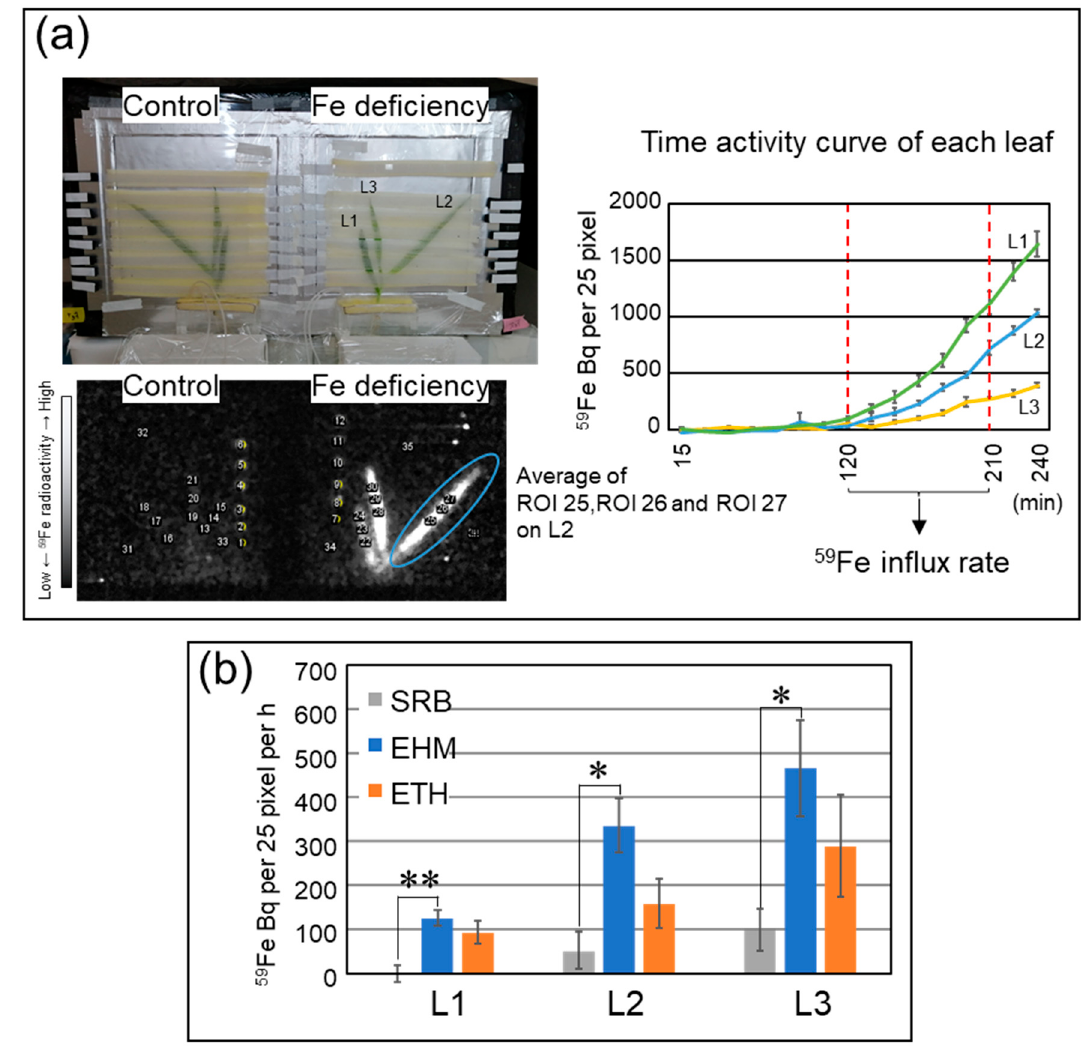
Figure 3. 59 Fe influx rate of Fe-deficient leaves detected by live-autoradiography. ( a ) Scheme for calculation of 59 Fe influx rate to leaves. Three regions of interest (ROIs) of 16 mm 2 (4 mm × 4 mm = 5 × 5 pixels) were set for each leaf, and average values of the three ROIs were calculated. Time–activity curves (TACs) for 59 Fe Bq per 16 mm 2 of each leaf were then generated. 59 Fe influx rate was calculated from the increase of radioactivity during a time window (120–210 min) when activity was linearly increased. ( b ) 59 Fe influx rate of each leaf was measured using three plants of each cultivar. Each TAC is represented in Figure S2. Only Fe-deficient leaves are represented, since the 59 Fe influx rates of control leaves were slow and sometimes undetectable. Gray bars, SRB; blue bars, EHM; orange bars, ETH. * p < 0.05 and ** p < 0.01 indicate significant differences (according to Student’s t -test) between the two cultivars.